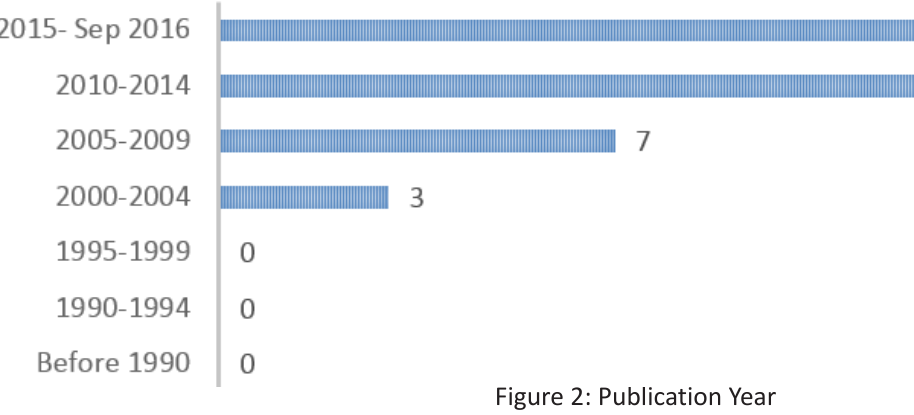
Figure 2: Publication